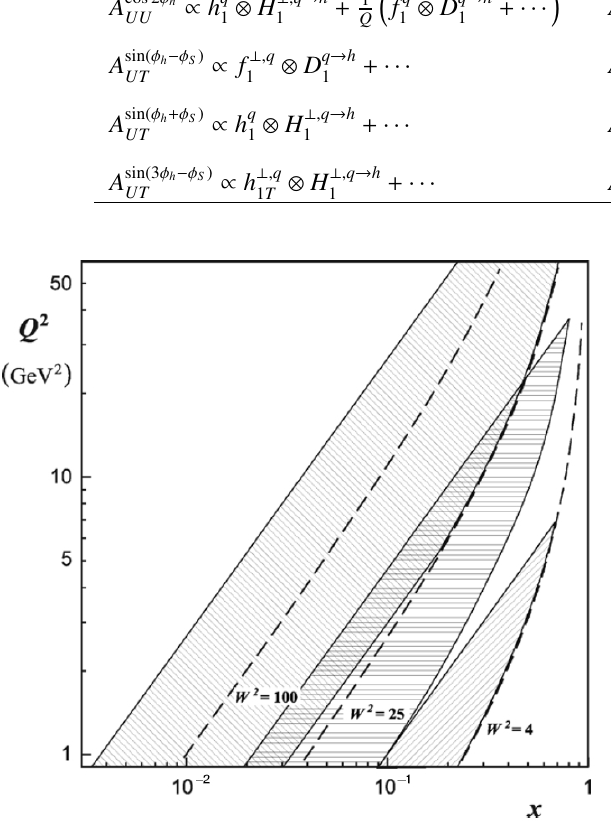
Figure 2. Phase space coverage of COMPASS, HERMES and